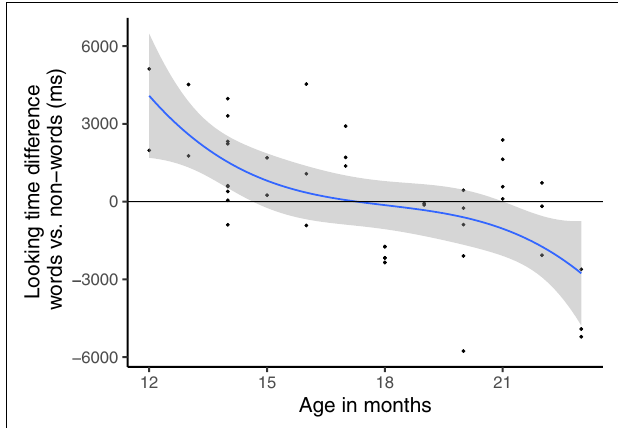
FIGURE 7 | Development of looking time difference for non-dialectal children across